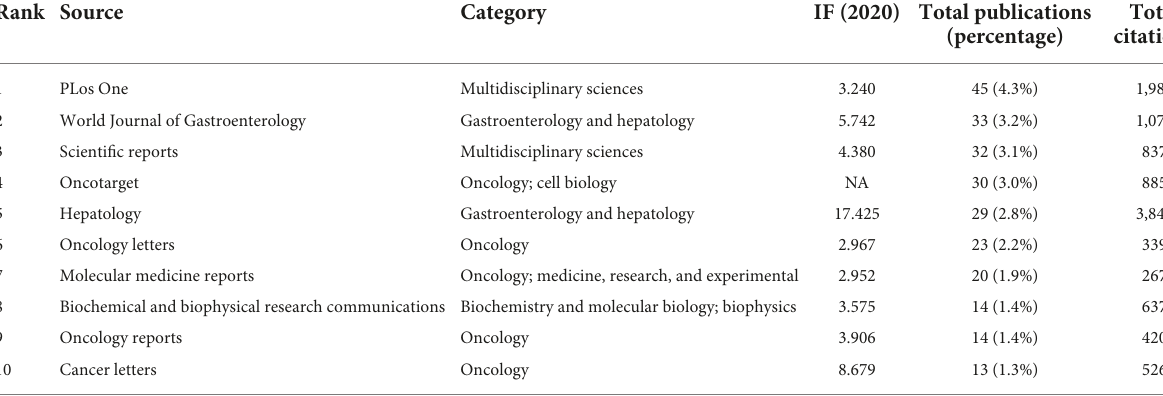
TABLE 1 The top 10 journals of publications on non-coding RNA and hepatitis B virus (HBV)-related hepatocellular carcinoma.